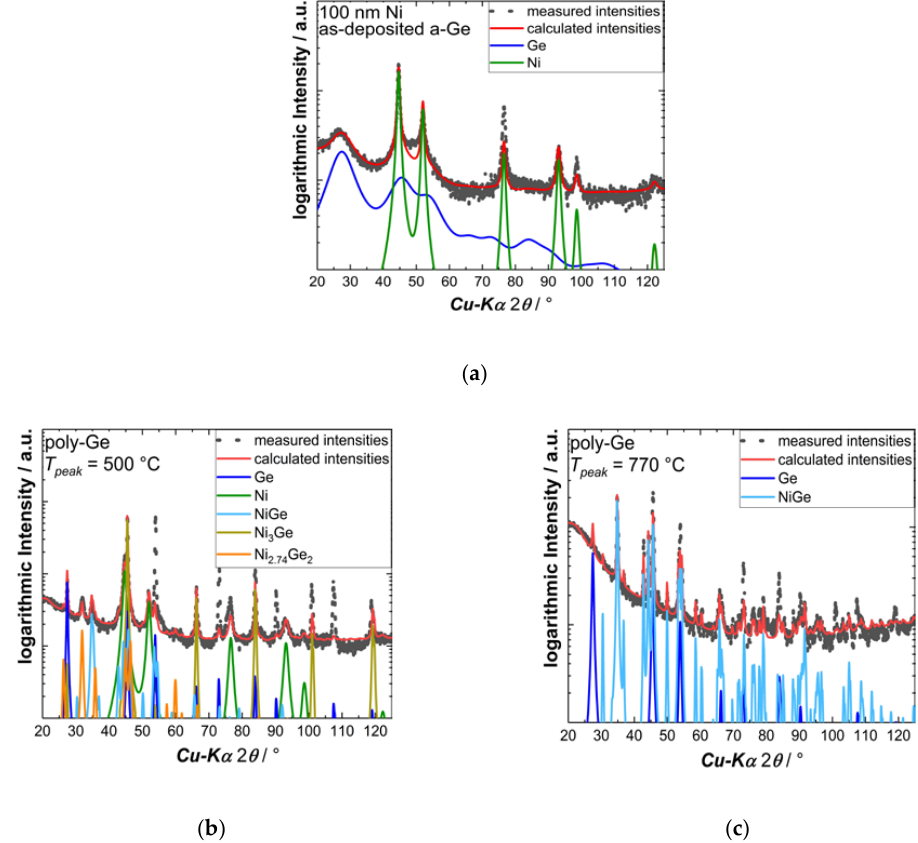
Figure 4. Grazing incidence X-ray di ff raction patterns (black points) and Rietveld fits (red) for: ( a ) as-deposited 100 nm Ni on 160 nm a-Ge, ( b ) and ( c ) 30 nm Ni on 160 nm poly-Ge at various peak temperatures. The Rietveld fits are composed of several phases for each sample which are shown in the same color for each